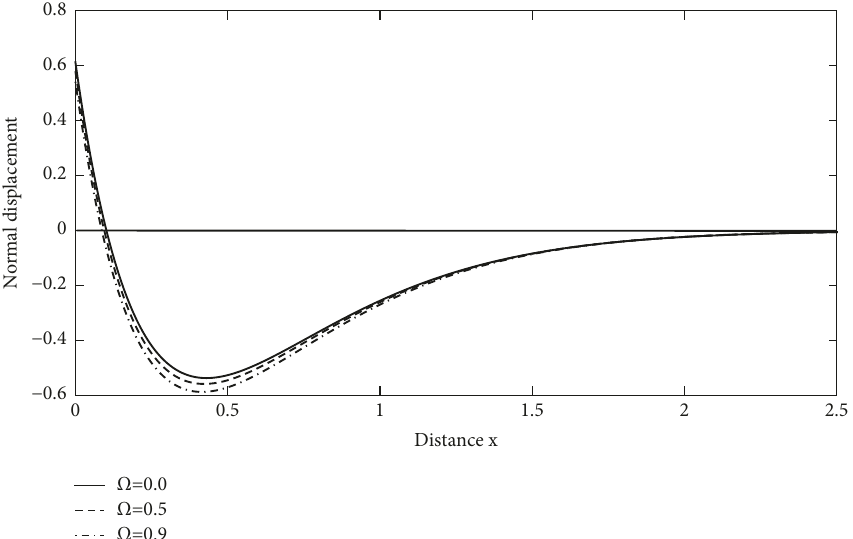
Figure 2: Effect of angular velocity on normal displacement distribution.